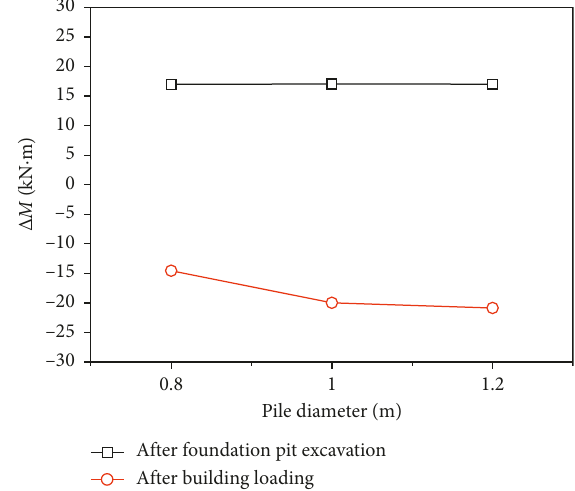
Figure 40: Difference between the additional bending